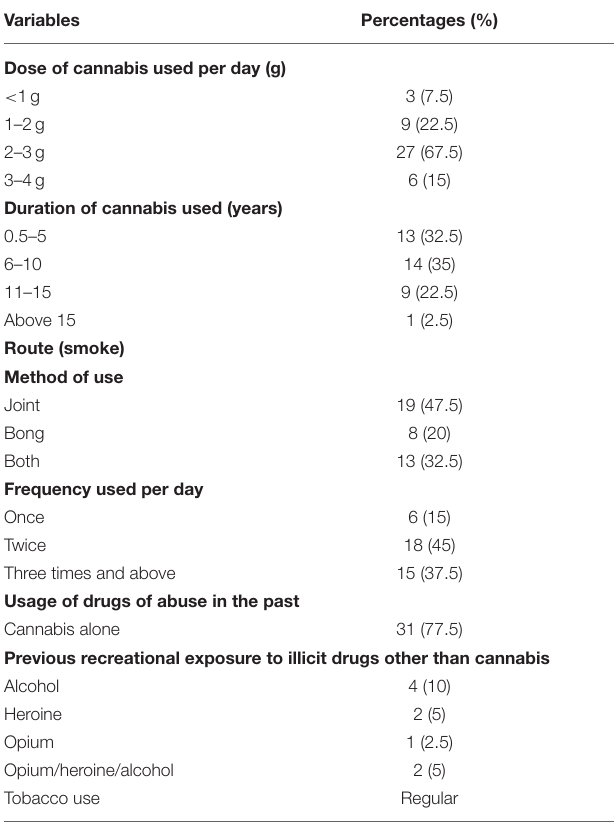
TABLE 6 | Cannabis-related variables for tolerance